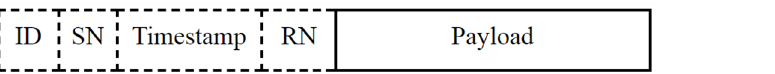
Figure 3. Data packet format. ID: identification of the packet type; SN: sequence number; RN: number of retransmission.